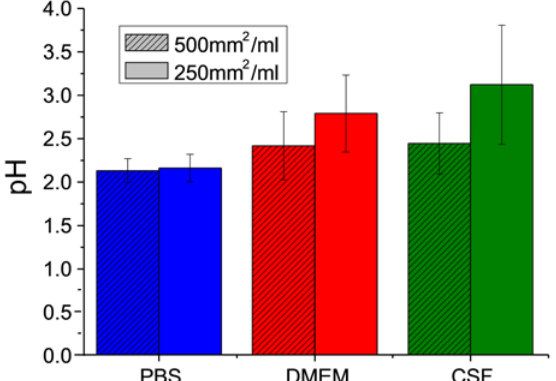
Figure 2. Analysis of oxidized regenerated cellulose (ORC)-dependent pH in phosphate buffered saline (PBS), supplemented culture medium (DMEM), and cerebrospinal fluid (CSF) determined with electron paramagnetic resonance (EPR) spectroscopy. Results of the pH measurements with the EPR probe HM (1 mmol/L) in 100 µL or 200 µL solution and 50 mm 2 (3.4 mg) Tabotamp ® . The diagram shows the means and standard deviations of three independent experiments.